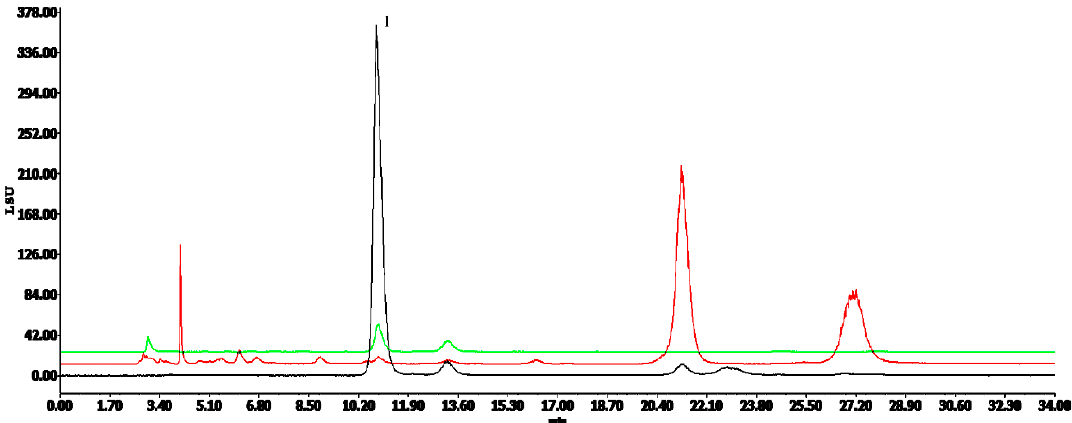
Figure 11. HPLC-ELSD chromatograms of P. ginseng primary water extracts, S. chinensis primary water extracts, and O. japonicus primary water extracts. (1: Fru). Table 3. The ranking value and score value of the three dimensions, the IMI, and ranking of the compounds.